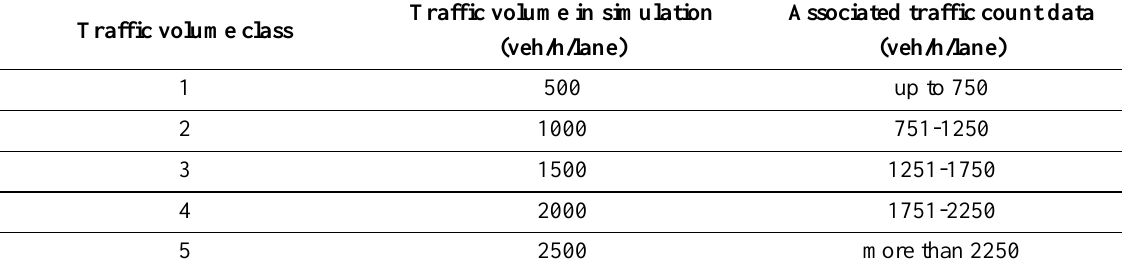
Traffic volume classes used in simulations and matched real-world traffic